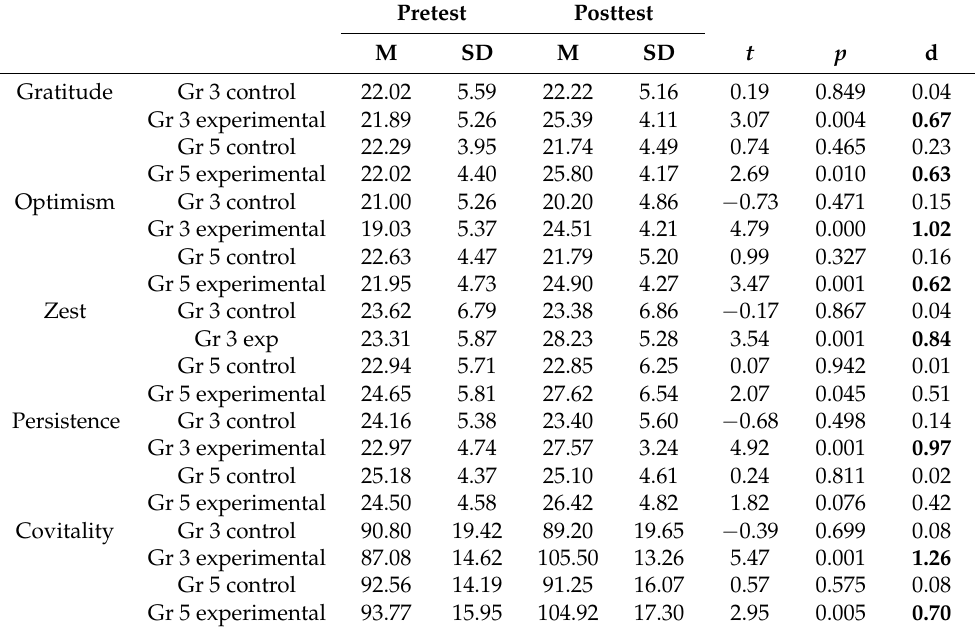
Table 2. Pretest and posttest measures for experimental and control groups.